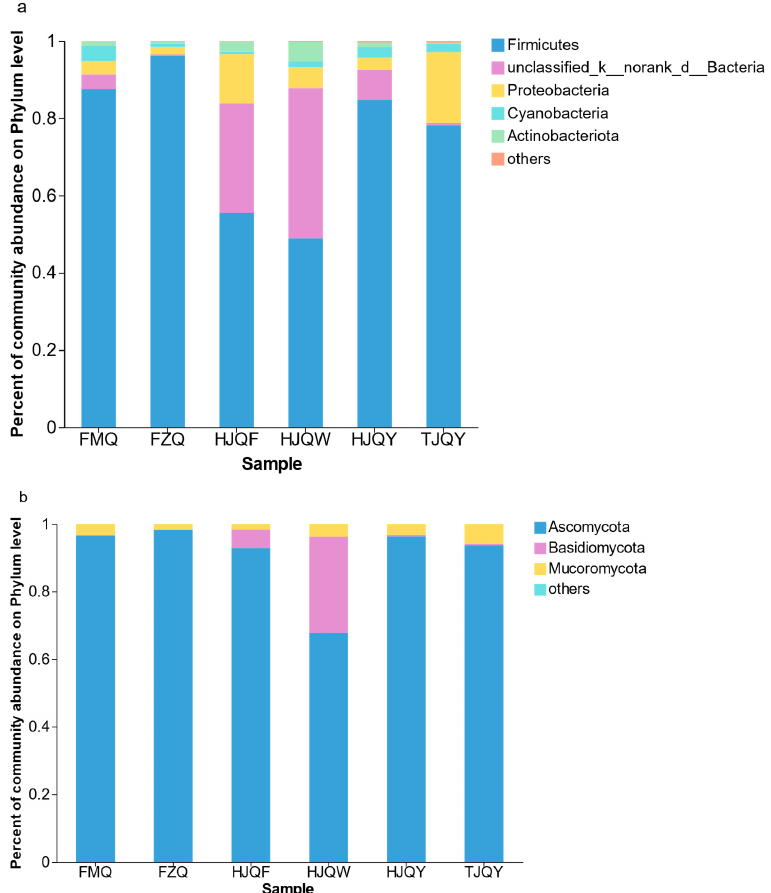
Figure 1. Microbial community composition at the phylum level of JIUYAO; ( a ): relative abundance of bacteria; ( b ) relative abundance of fungi. For the fungi, the ITS gene sequences were classified at the phylum, family, and ge- nus levels. The results showed that five fungal phyla, 39 families, and 69 genera were identified. The dominant floras at the phylum level with relative abundance above 0.1% were Ascomycota , Mucoromycota , and Basidiomycota (Figure 1b). At the genus level, 13 core fungi genera were detected (relative abundance > 1%) (Figure 2b), which included Wick- erhamomyces , Saccharomycopsis , Rhizopus , Candida , etc. Wickerhamomyces was the dominant fungi genus, followed by Saccharomycopsis and Rhizopus . In FZQ and FWQ, Wickerhamo- myces , Saccharomycopsis , and Rhizopus were the dominant fungi genera, and these three dominant fungi genera accounted for 99.67% and 99.29% of FZQ and FMQ, respectively. The proportions of the four dominating genera were above 1.00% in TJQY, including Wick- erhamomyces (84.96%), Saccharomycopsis (6.39%), Rhizopus (5.85%), and unclassifies_o_Sac- charomycetales (1.51%). The 10 dominating genera proportions were above 1.00% in HJQF, including Wickerhamomyces (37.09%), Saccharomycopsis (20.43%), Candida (18.17%), Api- otrichum (5.36%), etc. The six dominating genera proportions were above 1.00% in HJQW, including Geotrichum (30.83%), Apiotrichum (28.14%), Wickerhamomyces (14.84%), unclassi- fies_f_Dipodascaceae , etc. The six dominating genera proportions were above 1.00% in HJQY, including Wickerhamomyces (56.90%), Saccharomycopsis (11.95%), Clavispora (6.32%), unclassifies_f_Metschnikowiaceae , etc. In the yeasts, Wickerhamomyces has a strong flavor production ability, especially ethyl acetate [26], which provides rich fruit aroma for JIUYAO and the brewing of huangjiu [27]. It also can produce a small amount of ethanol. Saccharomyces is also an important flavor-producing yeast in the starters of huangjiu, and it has a high proportion in rice starters [14]. This strain can not only play an obvious role in aroma enhancement during brewing [28] but also has the characteristics of secreting amylase, which can work with saccharifying bacteria to improve the hydrolysis efficiency of raw materials. In the molds, Rhizopus is the dominant fungus in JIUYAO and an im- portant saccharifying bacteria, which has the ability to hydrolyze α -1,4 glycosidic bonds in starch and the ability to produce flavor compounds [29,30], and it can also secrete acidic protease [8]. Molds and some yeasts have the ability to secrete hydrolytic enzymes. Yeasts are primarily a producer of ethanol and flavor, and molds can also metabolize to produce flavor compounds combined with yeast metabolites. The two kinds of micro-organisms play a role in JIUYAO together to form a complex fungal community.